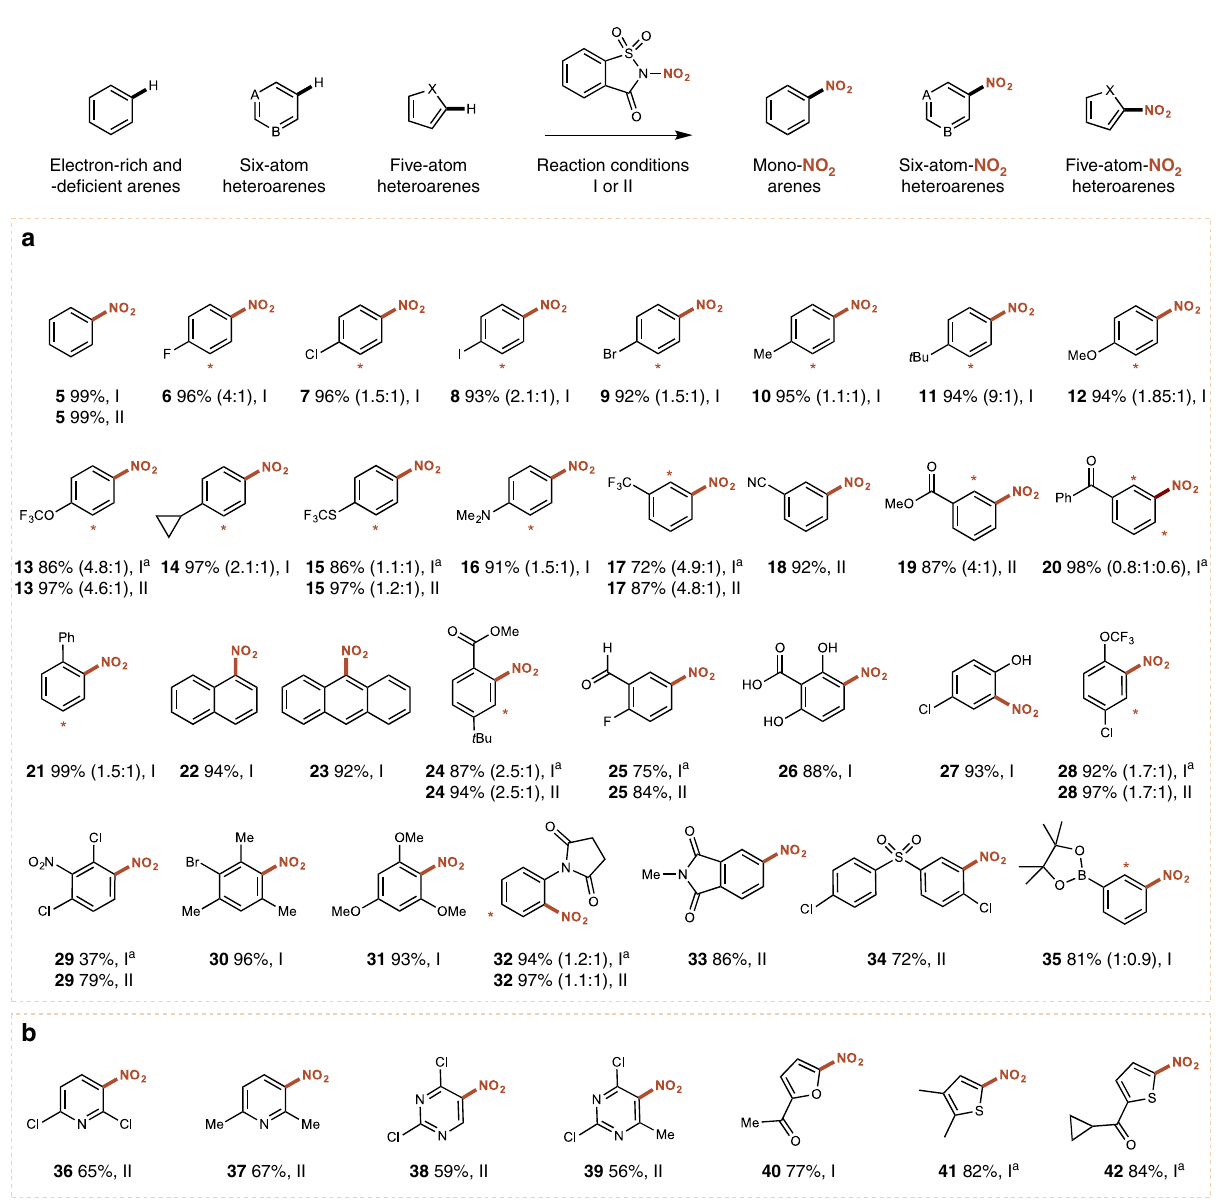
Fig. 2 Electrophilic nitration of arenes and fi ve- and six-membered heteroarenes using 4a . Standard procedures: I (Hetero)arene (0.5 mmol), 4a (0.65 mmol), HFIP (0.5 M), 55 °C, 3 h ([a], 19 h); II (Hetero)arene (0.5 mmol), 4a (0.65 mmol), [Mg(ClO 4 ) 2 ] (10 mol%), CH 3 CN (0.5 M), 85 °C, 5 h ([a], 19 h). Yields refer to the isolated product of a single regioisomer or a sum of separately isolated regioisomers. [*] The minor regioisomeric position is labeled. Scale up synthesis of 5 under conditions I (reaction run on 84.0 mmol of benzene; yield of 5 is 97%). a Nitration of small and